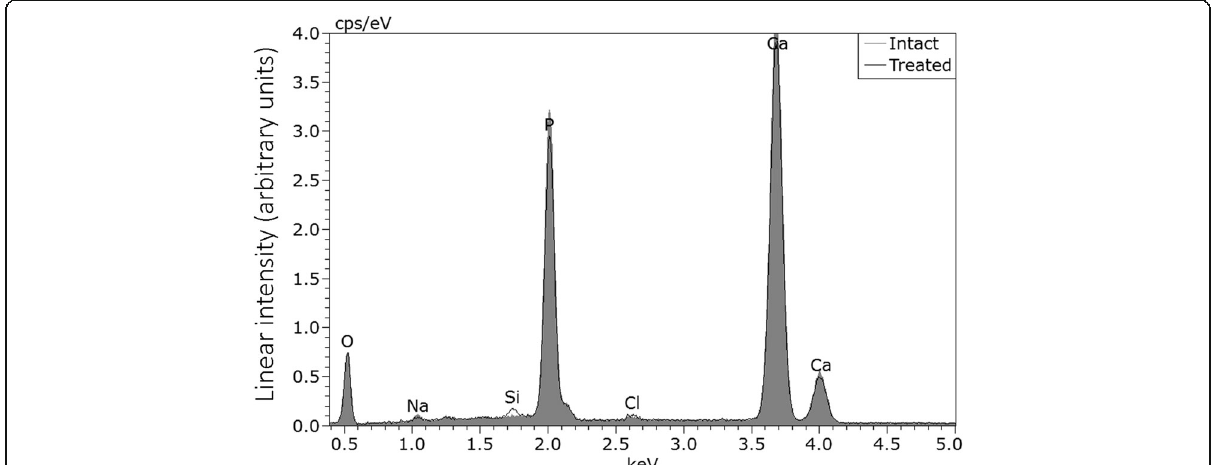
Fig. 4 Representative EDX spectra from the surfaces of intact and treated enamel. Gray area stands for intact while black line for treated enamel. Traces of Si were identified only on treated surfaces